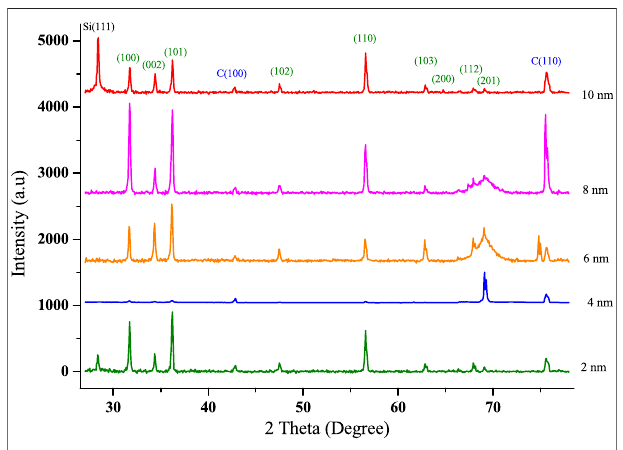
FIGURE 8 | XRD pattern of ZnO/CNT nanocomposites over annealed Au layer of various thicknesses on the Si substrate.